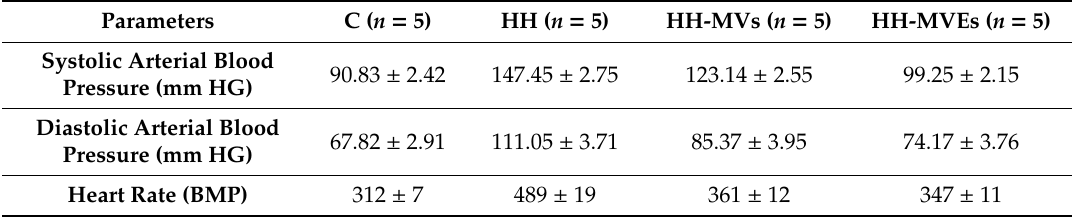
Table 3. Blood pressure readings as indicators of health or hypertension for hamster experimental groups: C, HH, HH-MVs, and HH-MVEs. The data correspond to the analysis done after 4 months of diet and